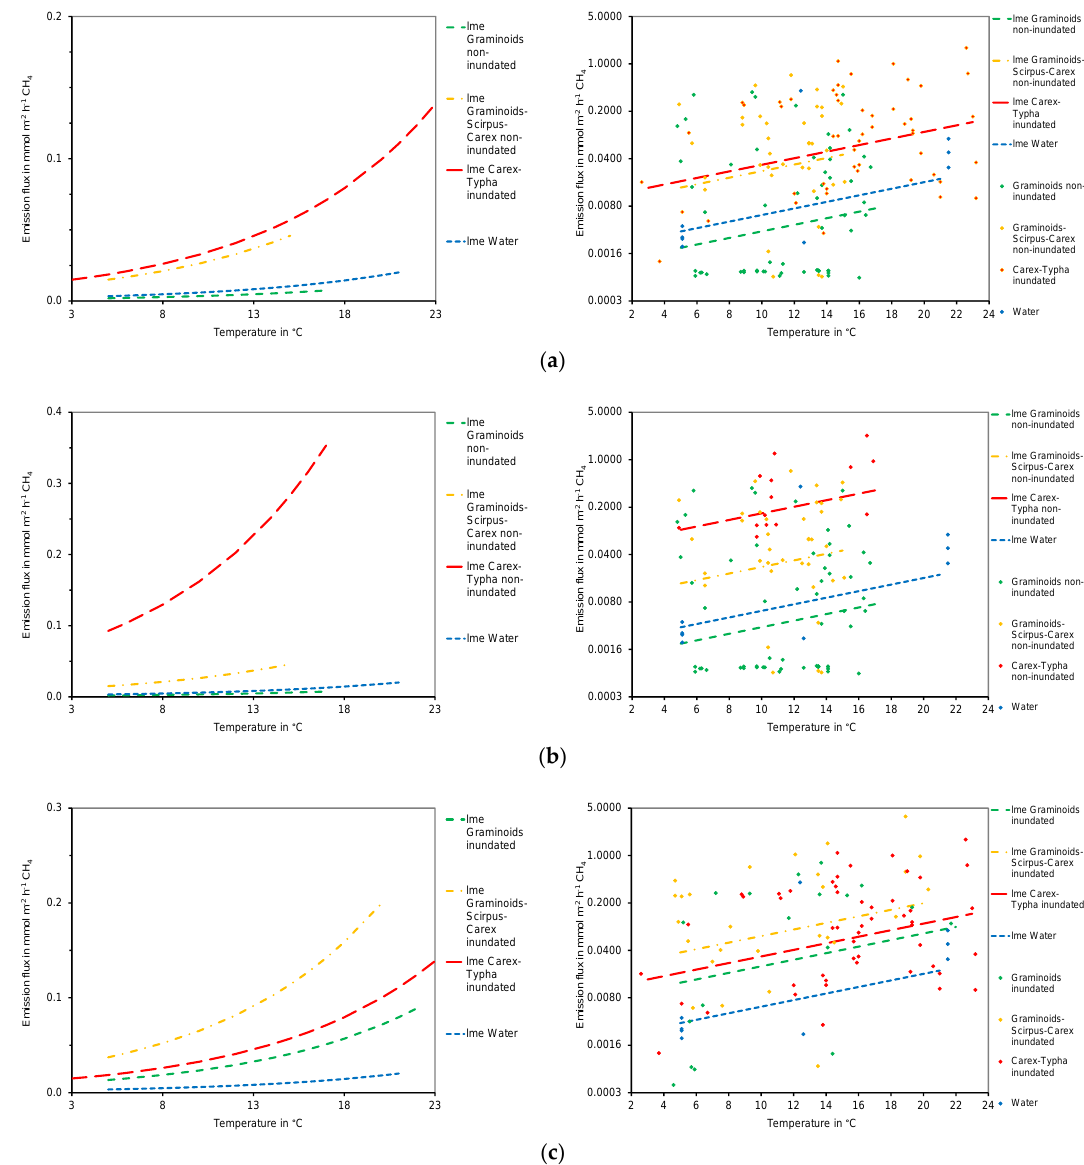
Figure 3. Flux of CH 4 (mmol m − 2 h − 1 ) related to soil or water temperature ( ◦ C) under: ( a ) ‘Normal’ conditions: Graminoids , Graminoids-Scirpus spp.- Carex spp. in non-inundated conditions and Carex spp.- Typha latifolia in inundated conditions (around 30 cm water depth); ( b ) ‘Dry’ conditions: all plant communities are situated above water level; ( c ) ‘Inundated’ conditions: all plant communities are situated below water level. Lines (left and right): Fluxes estimated with the linear mixed e ff ects (lme) model (cf. Table 3) based on measured temperature ranges; dots (right): fluxes estimated according to Equation (1). Note the log-scaled y-axes in the figures on the